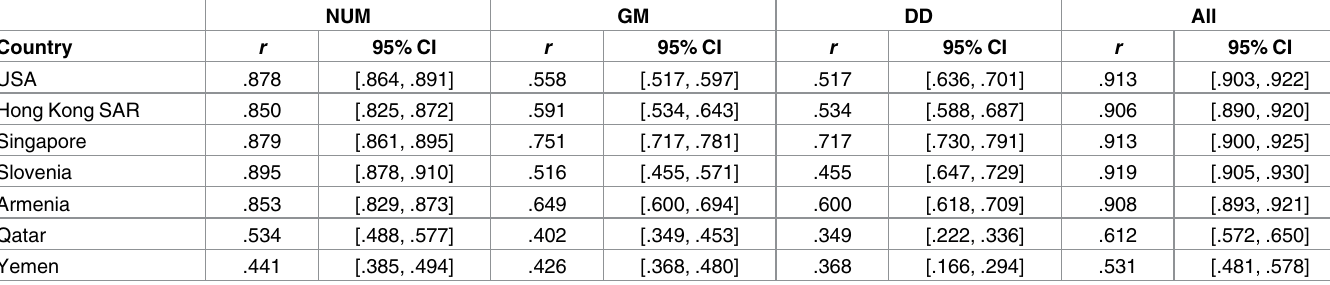
Table 7. Correlations between the unidimensional proficiency and the number of mastered